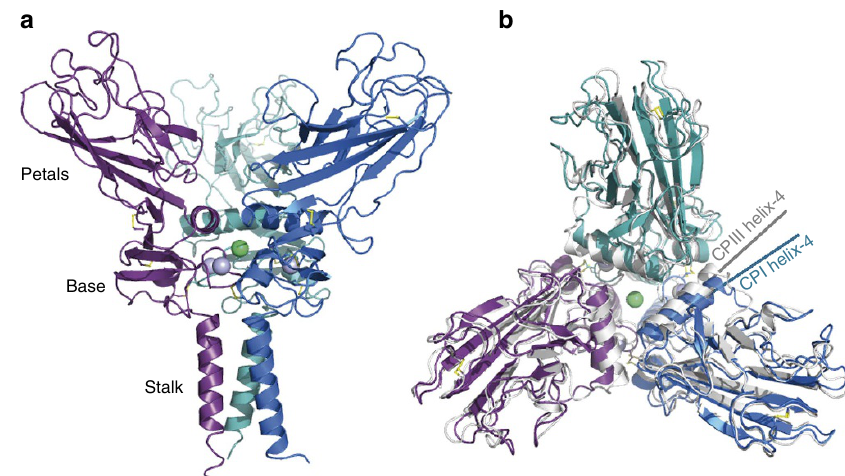
Figure 2 | 3D structure of homo-CPI. ( a ) View from the side showing the stalk, base and petal regions. Each chain is represented in a different colour, with bound Ca 2 þ ions as light blue spheres and the Cl (cid:2) ion in green. Disulfide bonds are in yellow. ( b ) View from the top showing a structural alignment of the homo-CPI structure (in colour) on the 3.3Å structure of CPIII (PDB code 4AK3; in grey). While overall the two structures are well aligned, there is a shift in orientation of helix-4 (highlighted for one chain from each